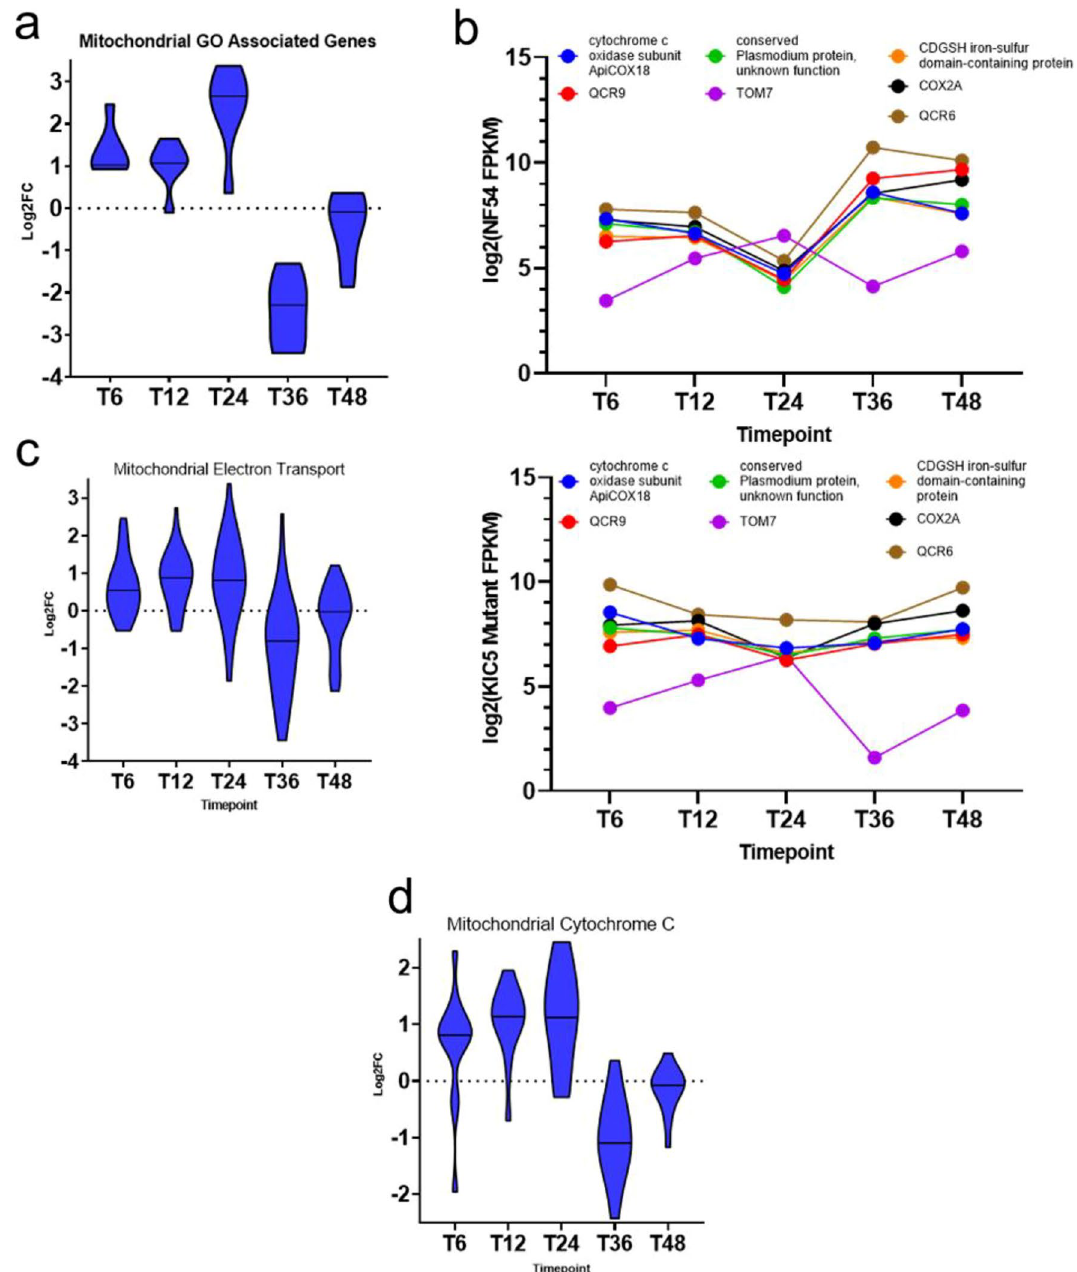
Figure 5. KIC5 disruption affects mitochondrial metabolism in P. falciparum. ( a ) Fold change analysis via violin plot shows upregulation of genes associated with top DE mitochondrial gene ontologies at 6–24 hpi (Supplementary Data file S10). Downregulation is seen at 36 hpi. Fold changes displayed as log2foldchange (log2FC; KIC5 mutant/NF54), and plots made in GraphPad Prism 9. ( b ) The expression patterns of several mitochondrial metabolic genes were found to be altered in the KIC5 mutant (right panel) from NF54 (left panel). Gene expression patterns plotted via log2(NF54FPKM) or log2(MutantFPKM) across five timepoints sampled in this study. Graphs created on GraphPad Prism 9. Using the Malaria Parasite Metabolic Pathways database, fold change analysis of genes involved in mitochondrial electron transport ( c ) and cytochrome c pathways ( d ) were found to have altered expression in the KIC5 mutant (Supplementary Table S13). Analysis identified an overall pattern of upregulation during early ring to early trophozoite stage and a noticeable downregulation at late trophozoite stage of these pathways. Dysregulation of mitochondrial pathways provides an additional link to altered ART-S and altered mitochondrial activity. Violin plotted using log2foldchange (KIC5 mutant/NF54) and created in GraphPad Prism